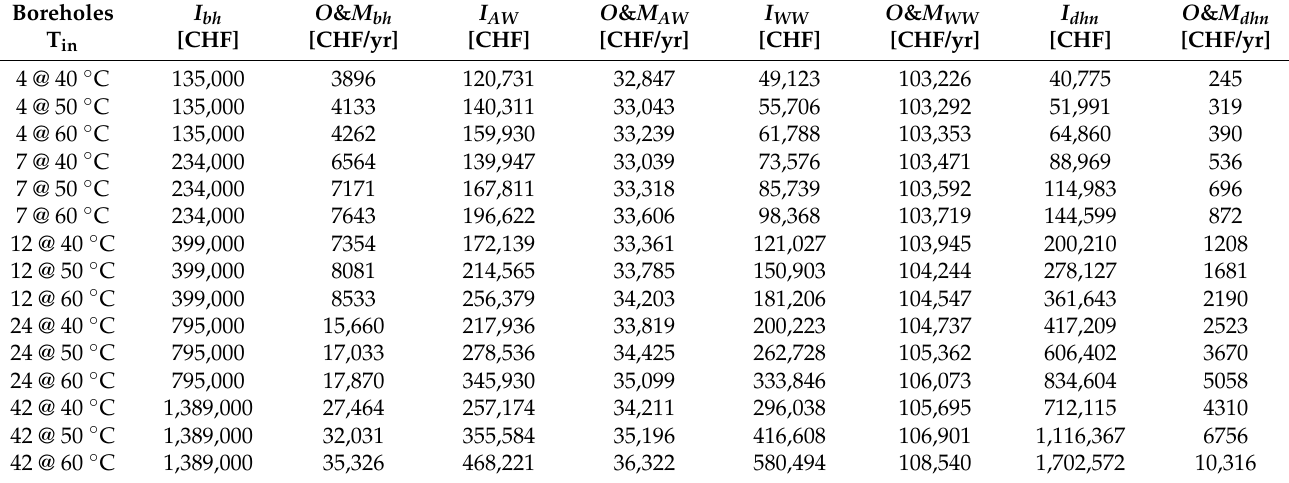
Table A2. Investment and O&M costs for the modeled